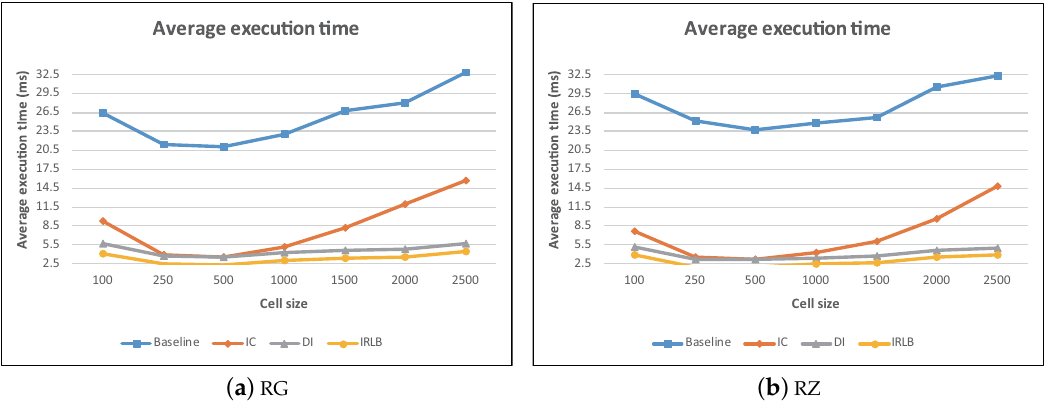
Figure 23. Average execution time vs. cell size. RG, Real Gaussian; RZ, Real Zipfian.